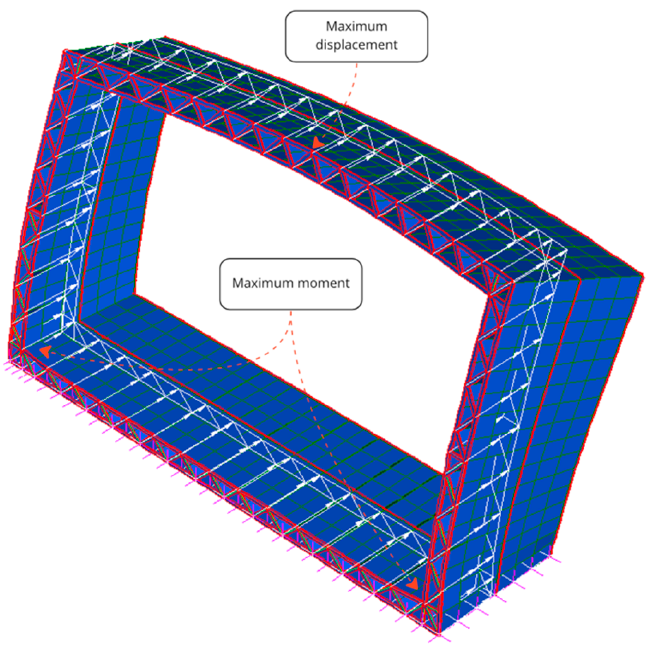
Figure 8. Deformed shape of DFF influenced by the wind load in the Z direction. A maximum lateral displacement of 0.0000128 m was recorded in the Z direction.